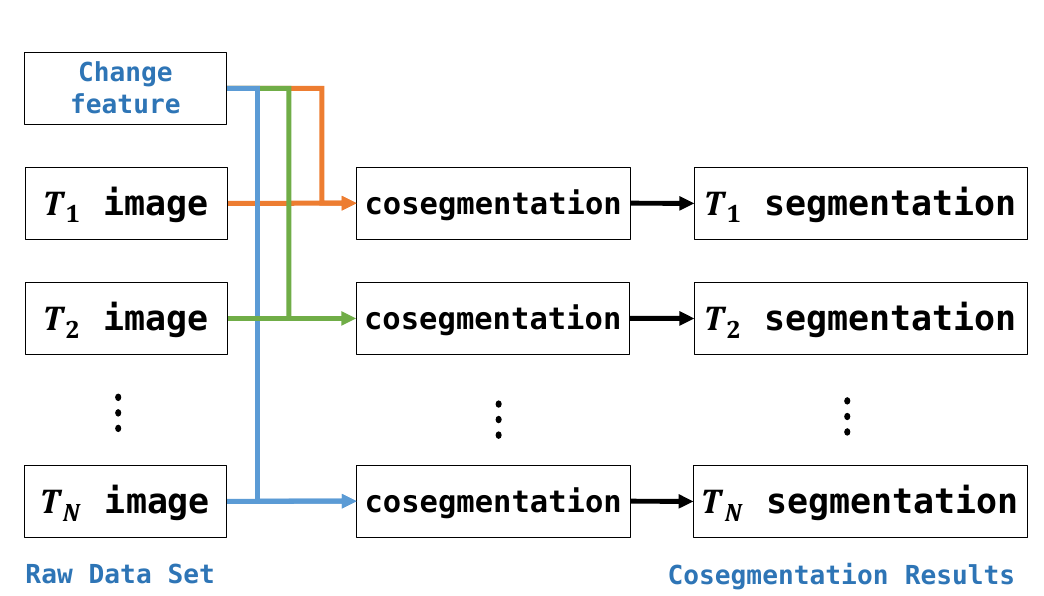
Figure 2. The workflow of cosegmentation strategy.